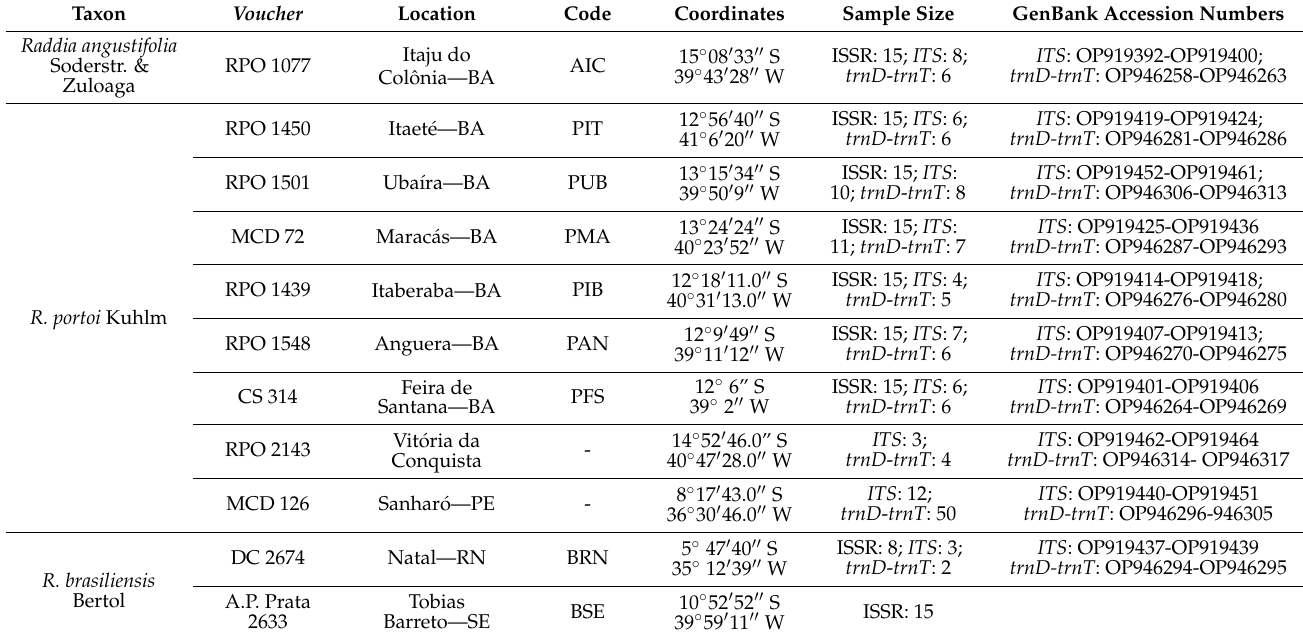
Table 4. Codes, localization, vouchers, data utilized, and accession numbers for Raddia populations in this